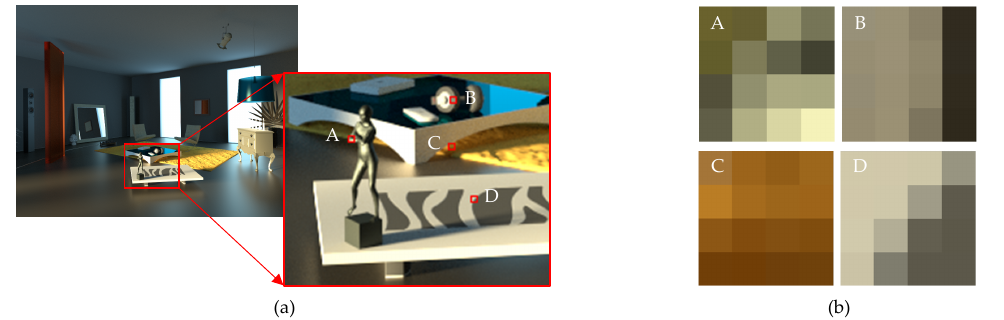
Figure 4. The color similarity within 4 × 4 pixel blocks in a single image (with permission from Ref. [35]). ( a ) the selected four 4 × 4 pixel blocks: A, B, C and D, ( b ) the enlarged pixel details for each